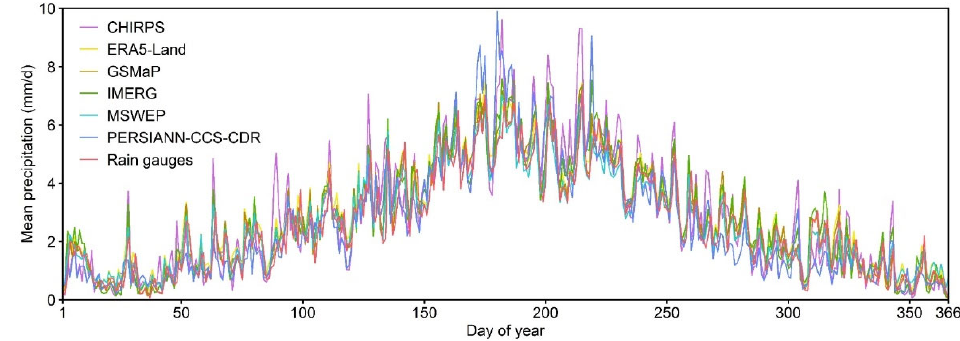
Figure 4. Mean time series of daily precipitation from rain gauges and six precipitation products during the year between 2015 and 2019. Table 3. Mean values of CC, RRMSE, POD and CSI for different seasons between 2015 and